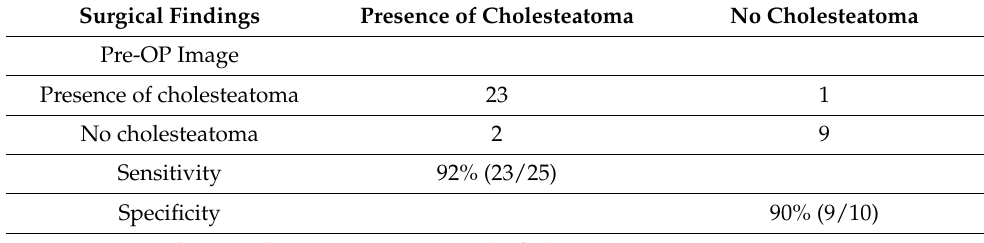
Table 2. The efficacy of preoperative DW-T1W-CT estimate on the presence of cholesteatoma.